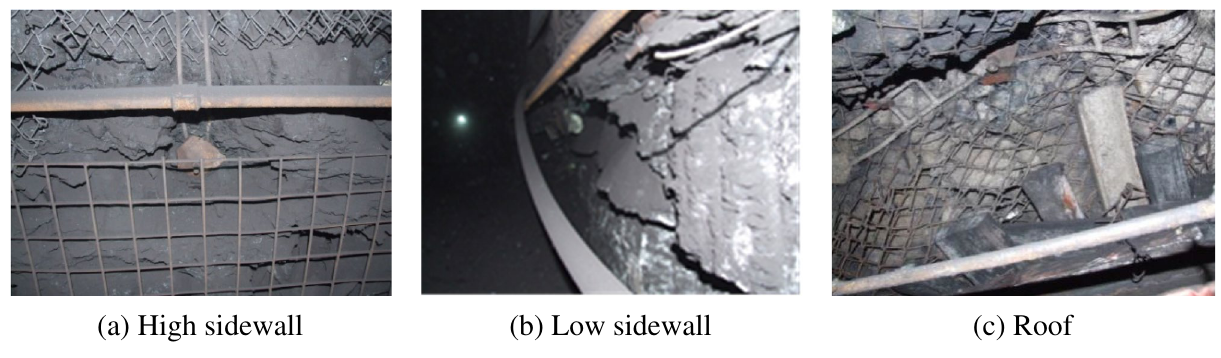
Figure 2. Deformation and destruction of roadway site.